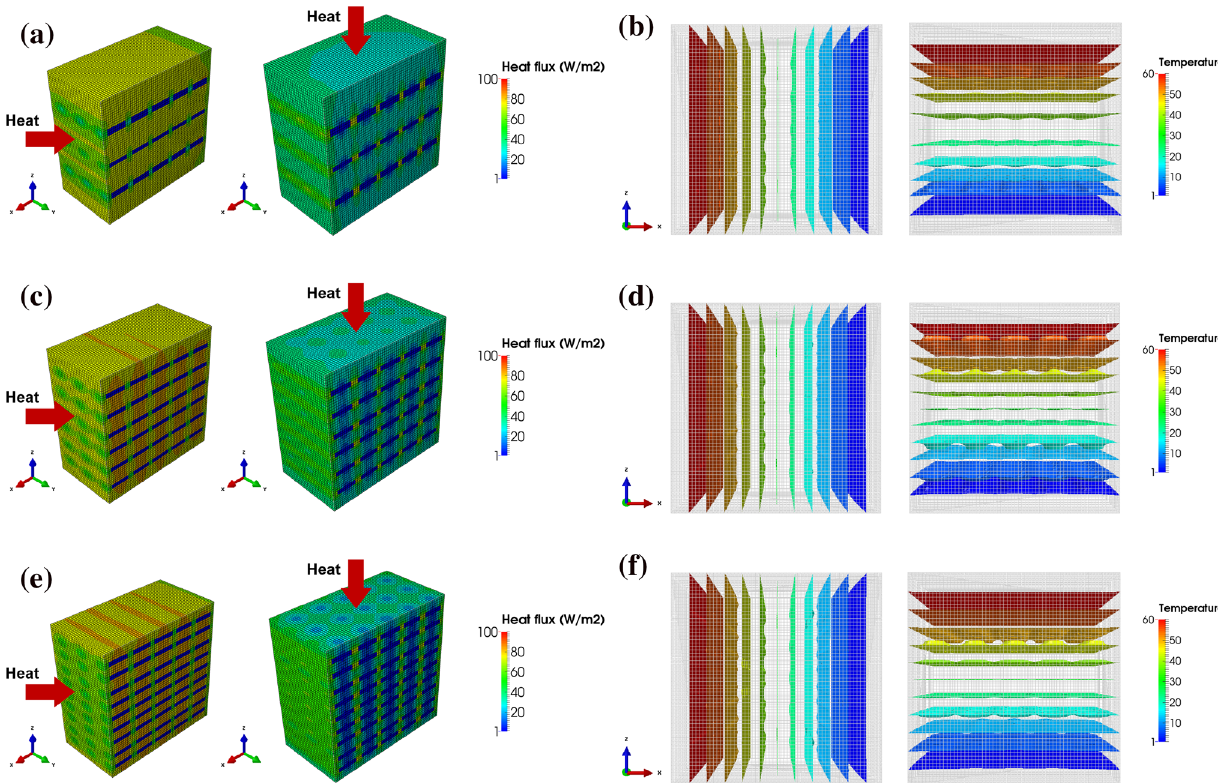
Fig. 6 The view cut of heat flux contour and temperature isosurface of the specimens with Rubber insulations for the x and z directions: a Heat flux of L3 sample, b Temperature isosurface of L3 sample, c Heat flux of L6 sample, d Temperature isosurface of L6 sample, e Heat flux of L9 sample, f Temperature isosurface of L9 sample ( Note In all figures, left figure is for the x -direction heat flow, and right figure is for the z -direction heat